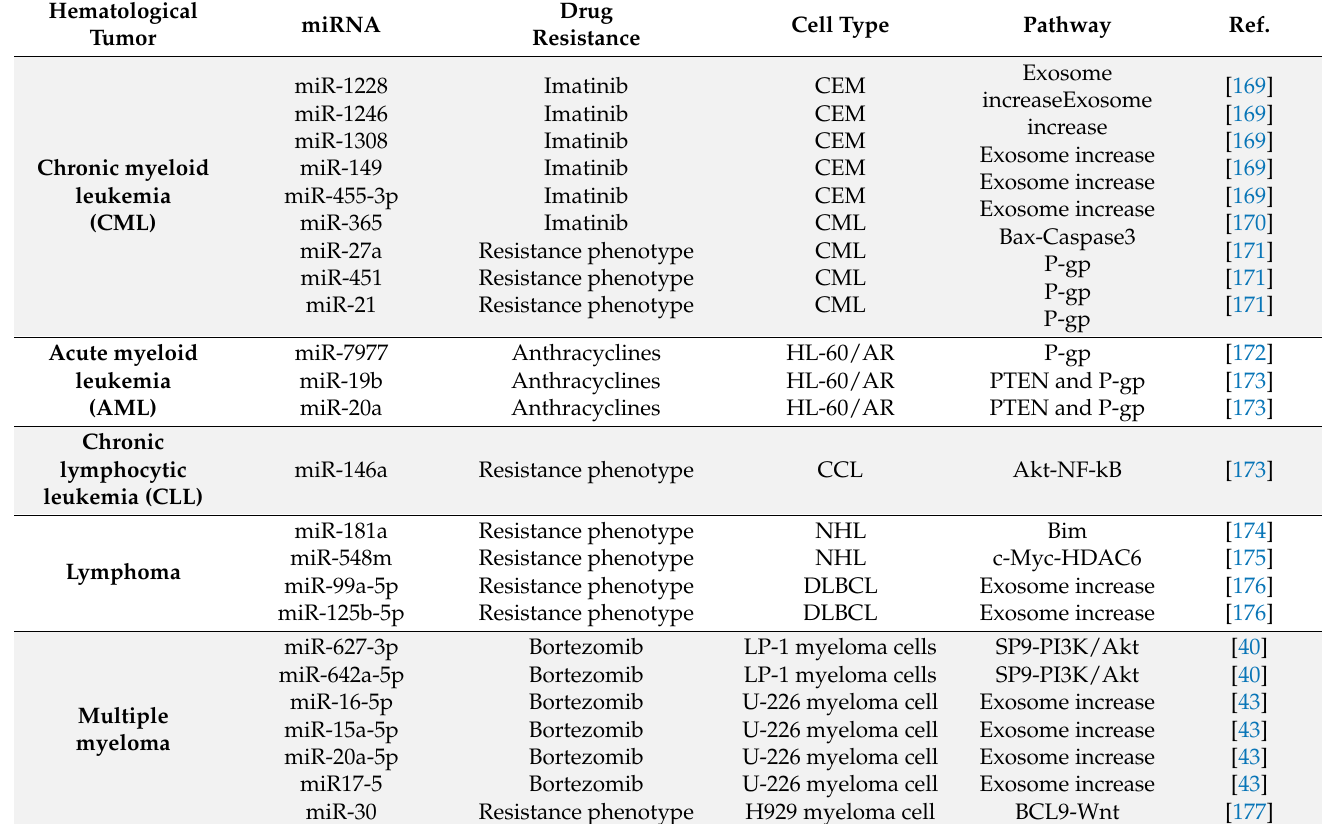
Table 1. Principal miRNAs involved in drug resistance (DR) of hematological tumor. Cell Type Pathway